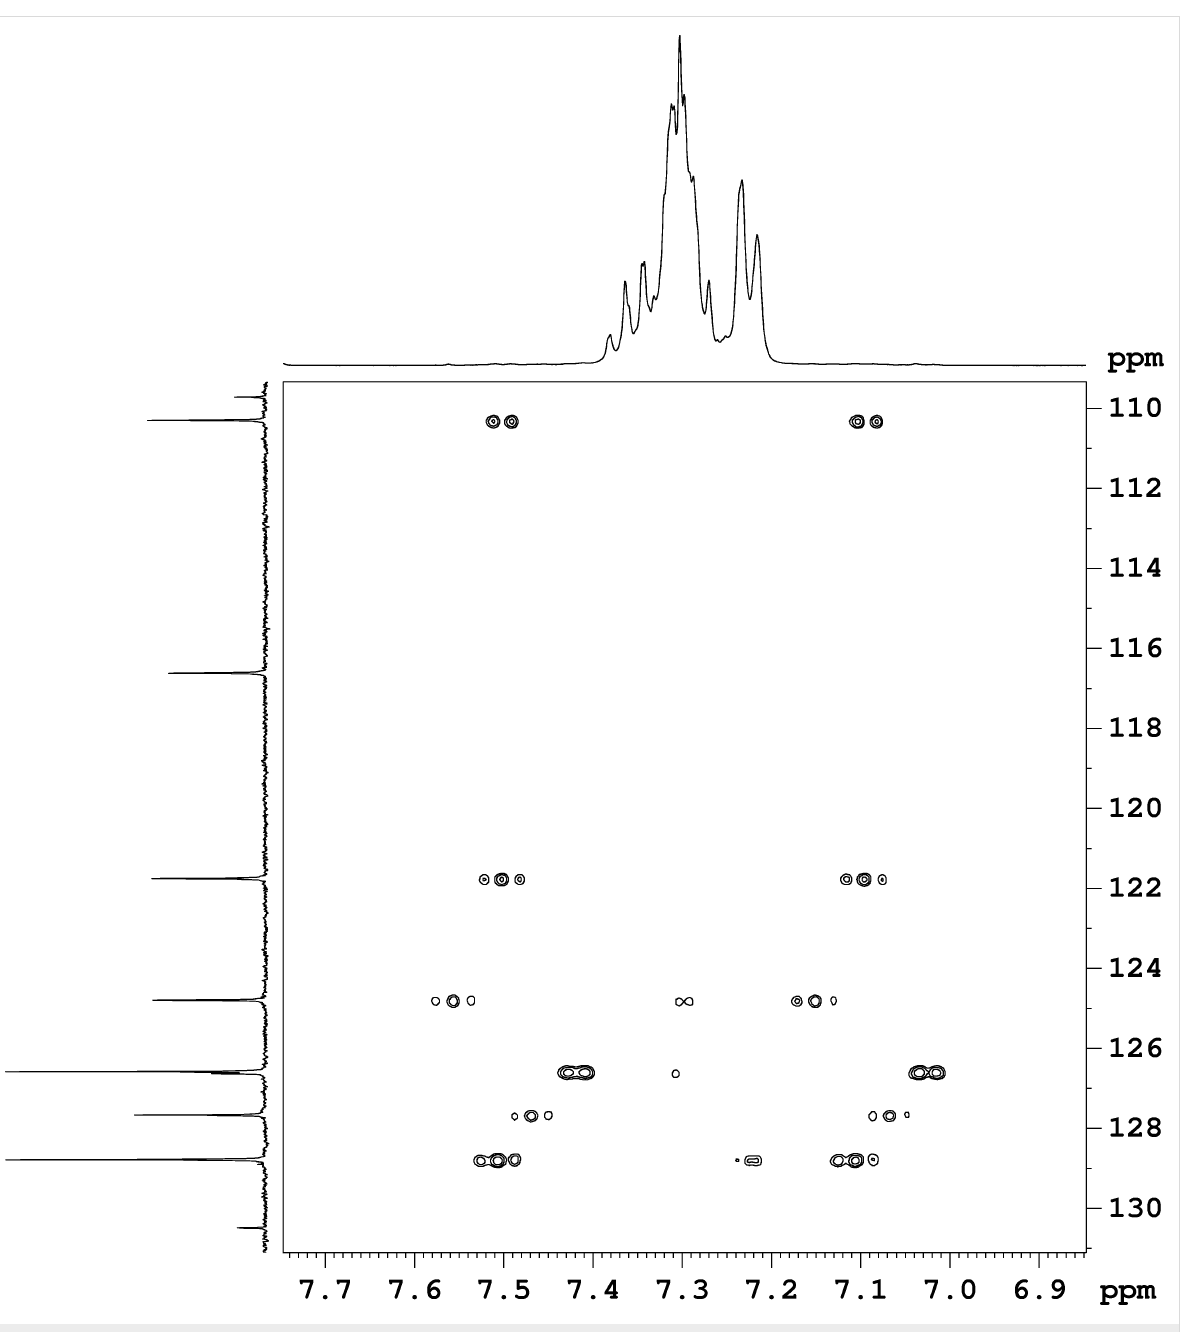
(Figure 2, bottom) the pseudo 1D 1 H spectra show individual signals allowing for the determination of chemical shifts, multi- plicities, and coupling